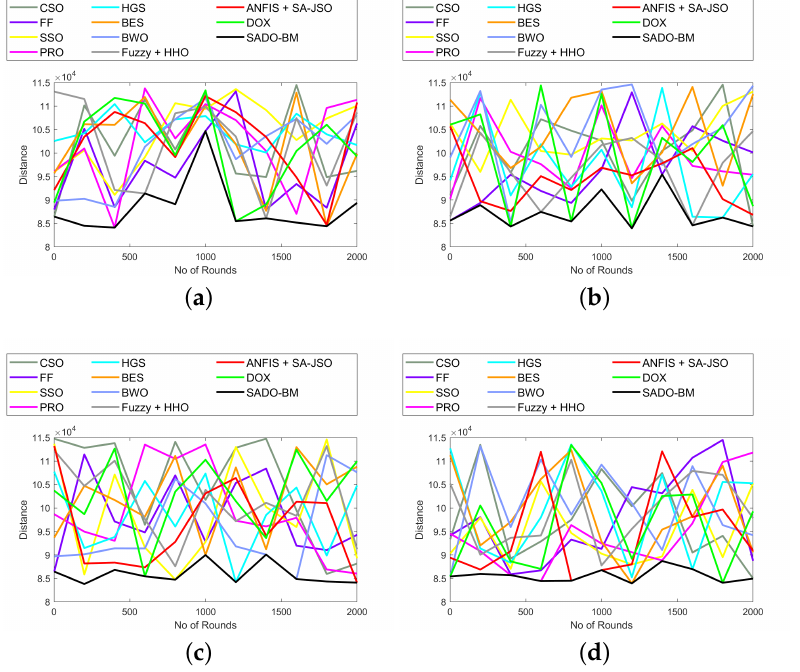
Figure 4. Distance analysis of SADO-BM over other models for node counts ( a ) 100, ( b ) 250 ( c ) 750, and ( d ) 1000.